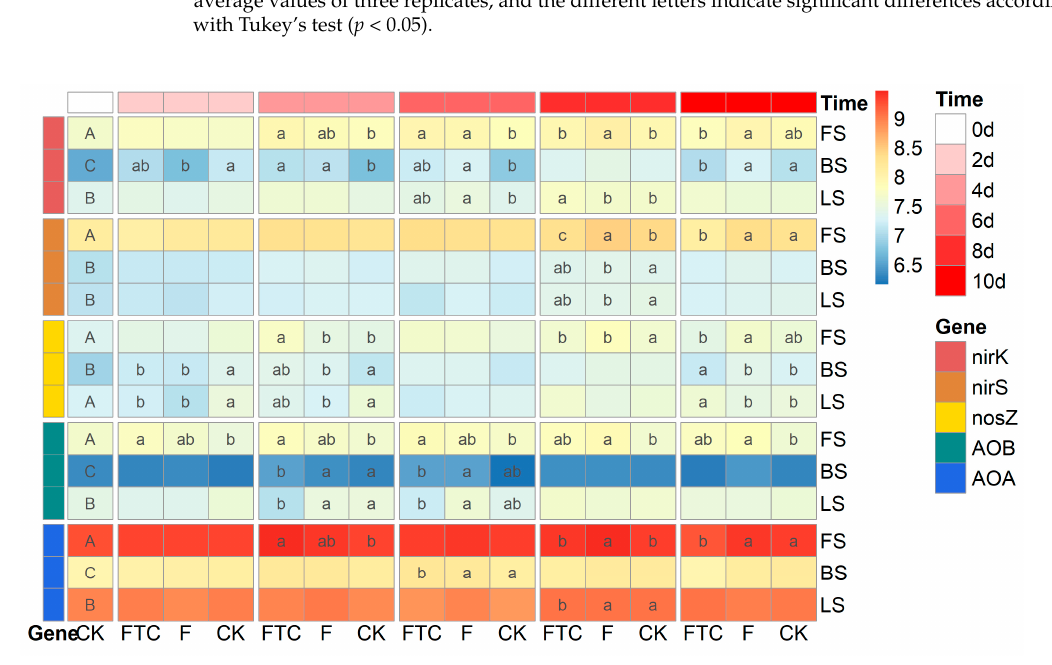
Figure 1. The absolute abundances of the nirK , nirS , nosZ , AOB amoA and AOA amoA genes (copies g − 1 dry soil), data were log-transformed; different uppercase letters at 0 d indicate that the gene abundance differed significantly among the three original soils, and different lowercase letters for the same time point indicate a significant difference in the gene abundance between the FTC, F and CK treatments for the same soil type based on Duncan’s test. CK: control treatment (10 ◦ C); F: freezing treatment ( − 10 ◦ C); FTC: freeze–thaw cycles ( − 10/10 ◦ C); AOA: AOA amoA gene; AOB: AOB amoA